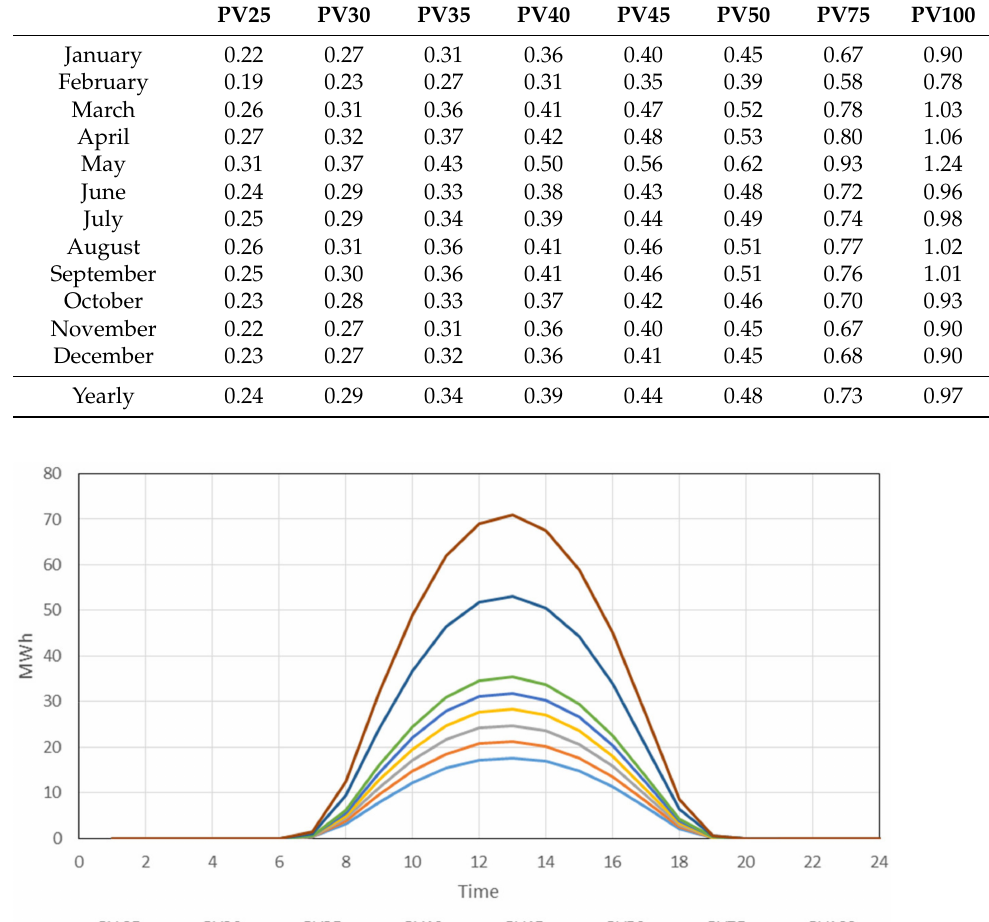
Figure 14. The annual distribution of electricity generation of PV systems for an average day.